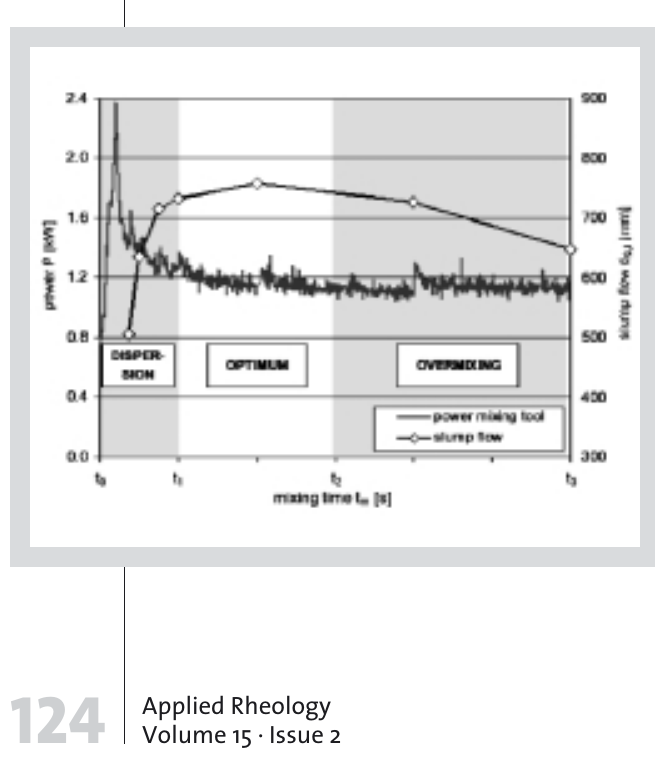
Figure 1: Effect of mixing